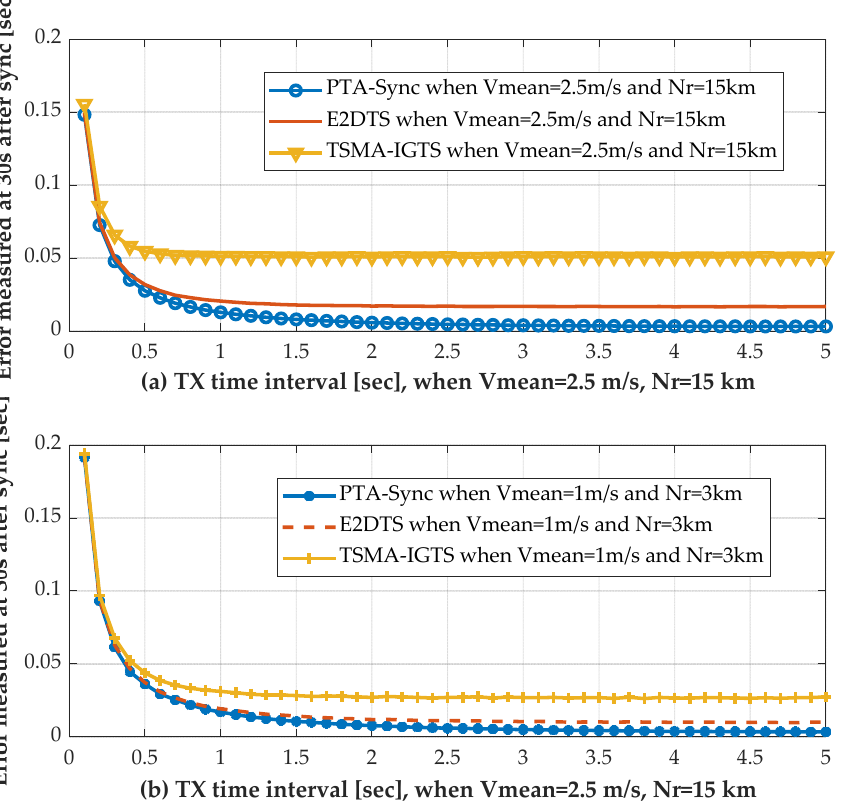
Figure 6. Time error measured at 30 s after synchronization versus I_tx when N_ex = 10 , T = 30 s, α = 0.5.